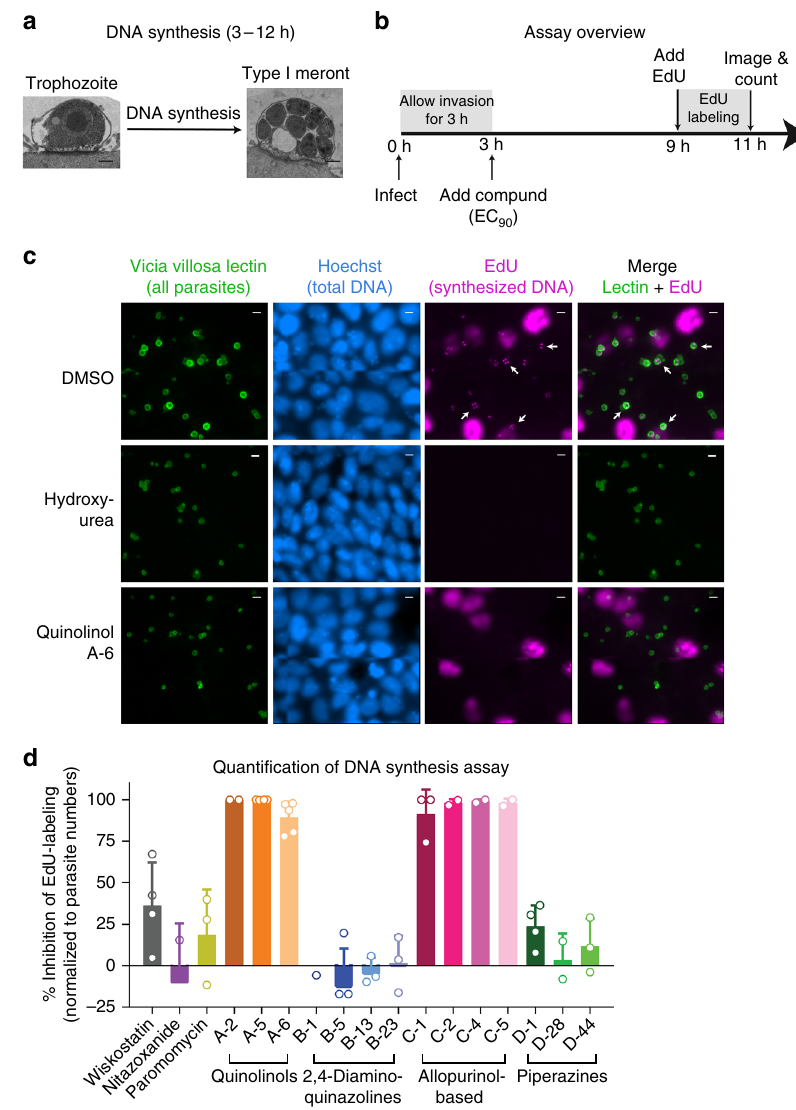
Fig. 3 DNA Replication Assay. a TEM images of C. parvum infected HCT-8 cells demonstrating parasite morphology at the time point that the DNA replication assay is performed (Scale = 500 nm). b Overview of the experimental method. Con fl uent HCT-8 cell monolayers in glass bottom plates were infected with C. parvum , and compounds were added at EC 90 following invasion. At 9 h post-infection, 10 µ M EdU was added, followed by incubation for another 2 h, and then washing, fi xing, and staining for microscopy. Note that images were acquired by focusing on parasite vacuoles, which typically reside in a different focal plane from the host cell nuclei. c Representative images of parasitophorous vacuoles (green), nuclei (blue) and EdU-labeling (magenta) after treatment with DMSO, EC 90 of quinolinol A-6 (MMV000760) (1.33 µ M), or 10 mM hydroxyurea. 40 × dry objective (NA = 0.7); scale = 5 µ m. Arrows indicate selected parasites with EdU-labeled DNA. d Quanti fi cation of EdU incorporation. The compounds in the quinolinol and allopurinol-based series (denoted a and c , respectively) inhibited EdU incorporation. Data are mean and SD of 2 – 5 biological replicates. Source data are provided as a Source Data fi distinguish pre-existing DNA from newly synthesized DNA (Fig. The 2,4-diaminoquinazolines B-1 (Fig. 3c). In contrast, EdU labeling only occurred with incor- (MMV006169)), which inhibited host cell invasion, had no poration into newly synthesized DNA. Incorporated EdU was effect on intracellular DNA replication. Results for the other then easily stained for immuno fl uorescence and labeled parasites compounds were also consistent within chemical groups: the were quanti fi ed using high-content microscopy and an NIH ImageJ macro (Fig. 3c, DMSO condition). The thymidine analog blocked C. parvum DNA replication, while the piperazine-based hydroxyurea (10 mM), a known inhibitor of DNA replication, scaffold (parent D-1 (MMV665917)) and paromomycin had no was used as a positive control for assay validation. As expected, effect on EdU incorporation (Fig. 3d). Compounds with activity hydroxyurea at this concentration blocked both parasite and in this assay cannot be concluded to speci fi cally target DNA HCT-8 cell DNA replication (Fig. 3c). The MMV Malaria Box replication, which is a complex phenotype. Also, as is evident quinolinol A series, compounds previously identi fi ed as selective from the images, it would be feasible to enumerate the number of C. parvum inhibitors, blocked C. parvum DNA replication nuclei present in each vacuole to obtain subtler information; without affecting host cell DNA replication when applied at EC 90 however, for the purpose of classifying compounds according to